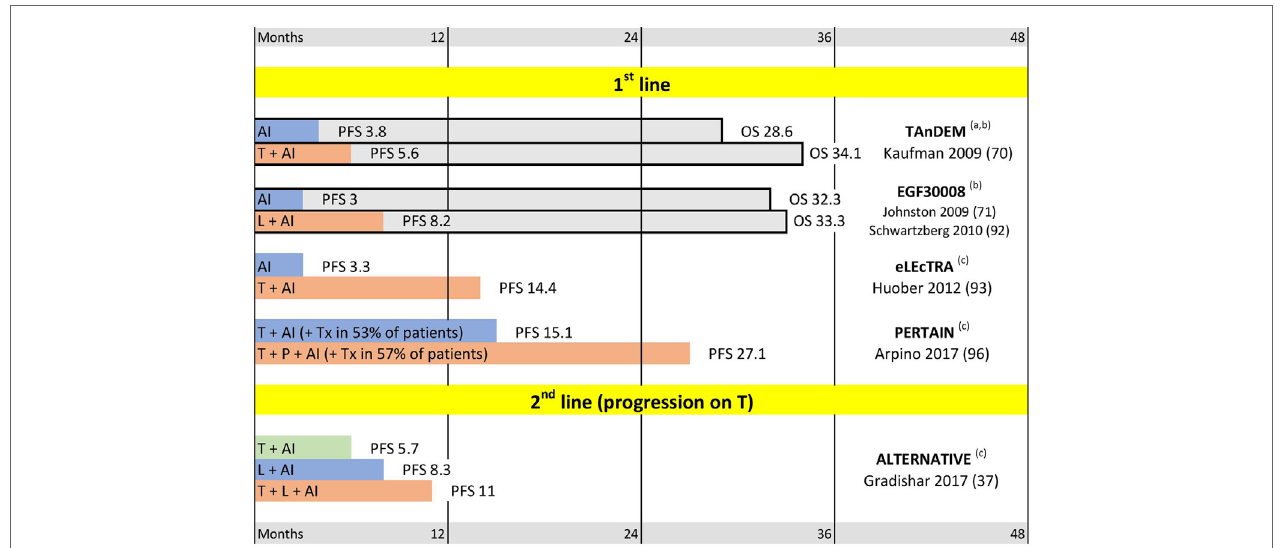
FiGURe 3 | Triple positive breast cancer trials. Abbreviations: T, trastuzumab; P, pertuzumab; L, lapatinib; AI, aromatase inhibitor. (a) Mixed first line and later lines; median progression-free survival (PFS) and median overall survival (OS) for patients with centrally confirmed estrogen receptor. (b) OS trend not significant. (c) OS not reported. Median PFS and OS are indicated in